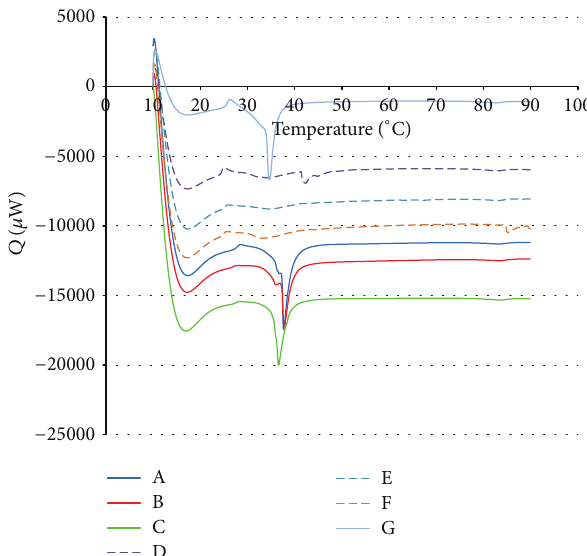
Figure 2: Calorimetric determination of gelatin samples prepared with and without UV irradiation. (A–C) Control samples with glucose and without irradiation. (D–F) UV-irradiated samples with glucose. (G) Control samples without glucose and without